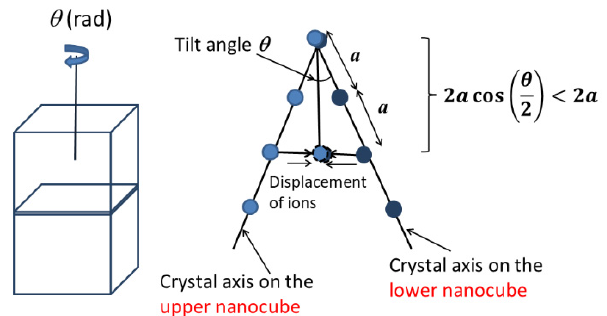
Figure 9. Misfit strain ( right ) caused by a small tilt angle θ between two attached BaTiO 3 nanocubes ( left ). The right figure is the projection view of the interface from the above. Two corresponding crystal axes are shown in the figure. The small circles are Ba ions. Reprinted with permission from Ref. [86]. Copyright 2020, IOP Publishing.